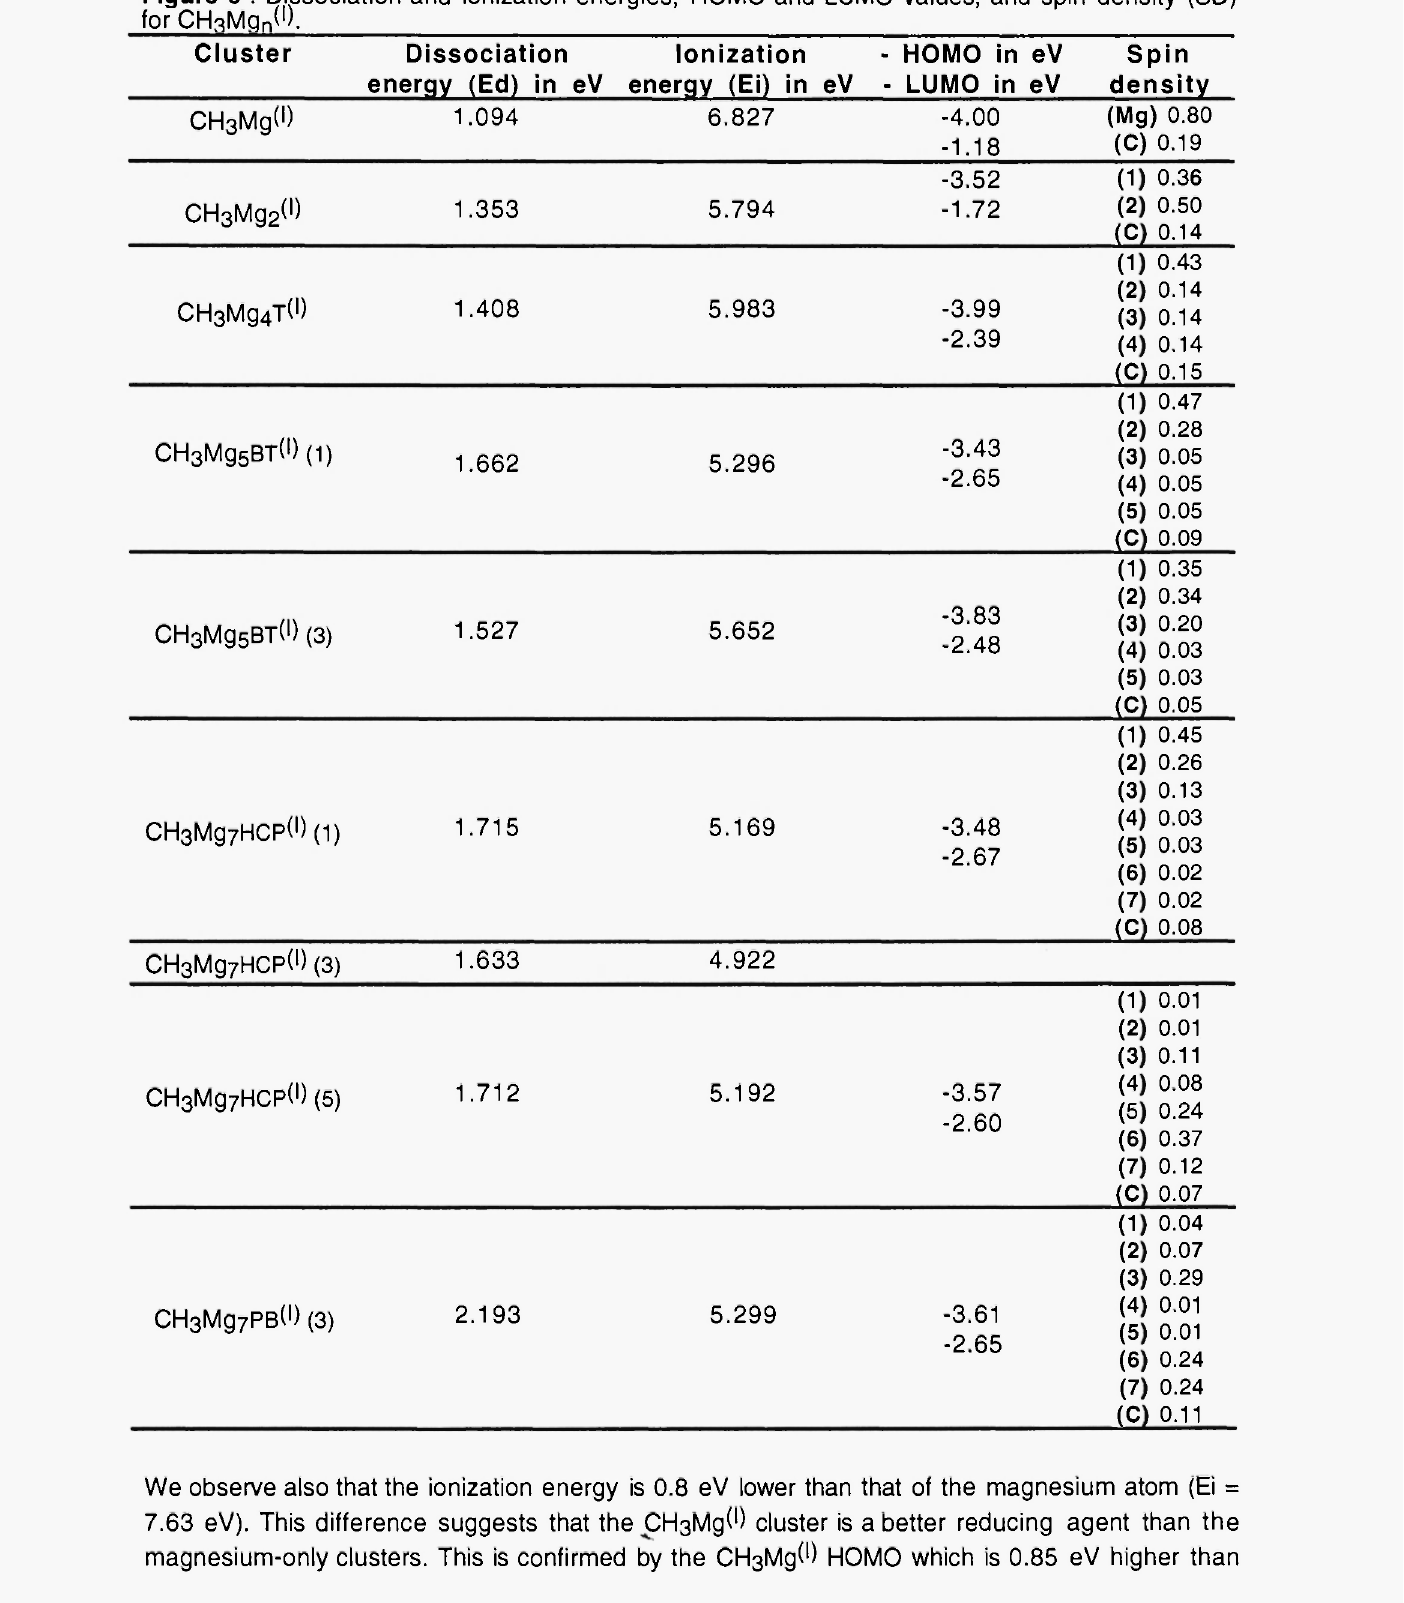
Figure 6 : Dissociation and ionization energies, HOMO and LUMO values, and spin density (SD) for